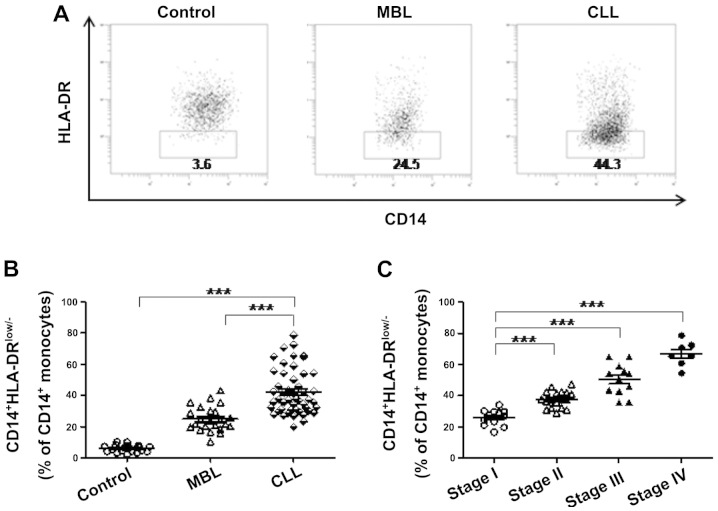
The CD14+HLA-DRlow/− MDSCs are upregulated in CLL patients. (A) Representative HLA-DR expression in CD14+ monocyte population of the control group, MBL patients and CLL patients. (B) Frequency of CD14+HLA-DRlow/− MDSCs in CD14+ monocytes of CLL patients (42.1±14.5%; n=49) were significantly elevated compared with MBL (24.95±8.1%; n=23) and control (6.1±2.2%; n=21) patients (both were P<0.0001). (C) Frequency of CD14+HLA-DRlow/− MDSCs in CD14+ monocytes were significantly increased in advanced stages compared with the stage I CLL patients (stage II: n=18; P<0.0001; stage III: n=12; P<0.0001; stage IV: n=7; P=0.0005). ***P<0.001. CD14, cluster of differentiation 14; HLA, human leukocyte antigen; MDSCs, myeloid-derived suppressor cells; CLL, chronic lymphocytic leukemia; MBL, monoclonal B cell lymphocytosis.